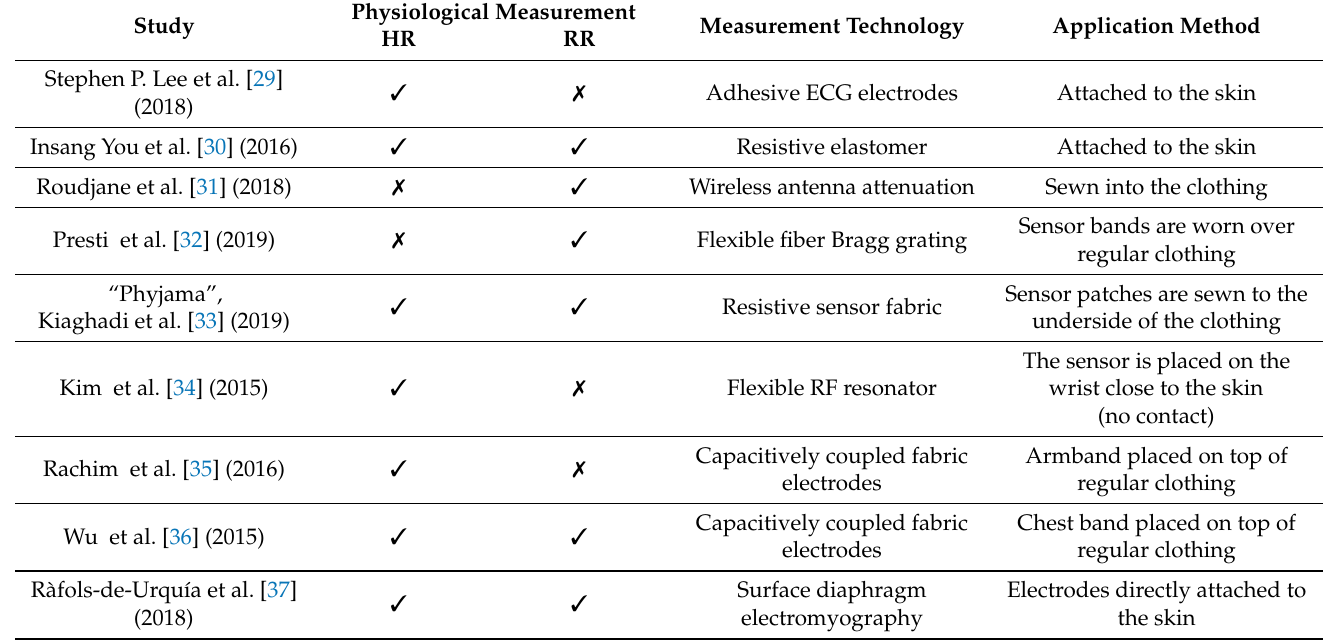
Table 1. Physiological monitoring wearables summarized based on measurement technology and sensor application